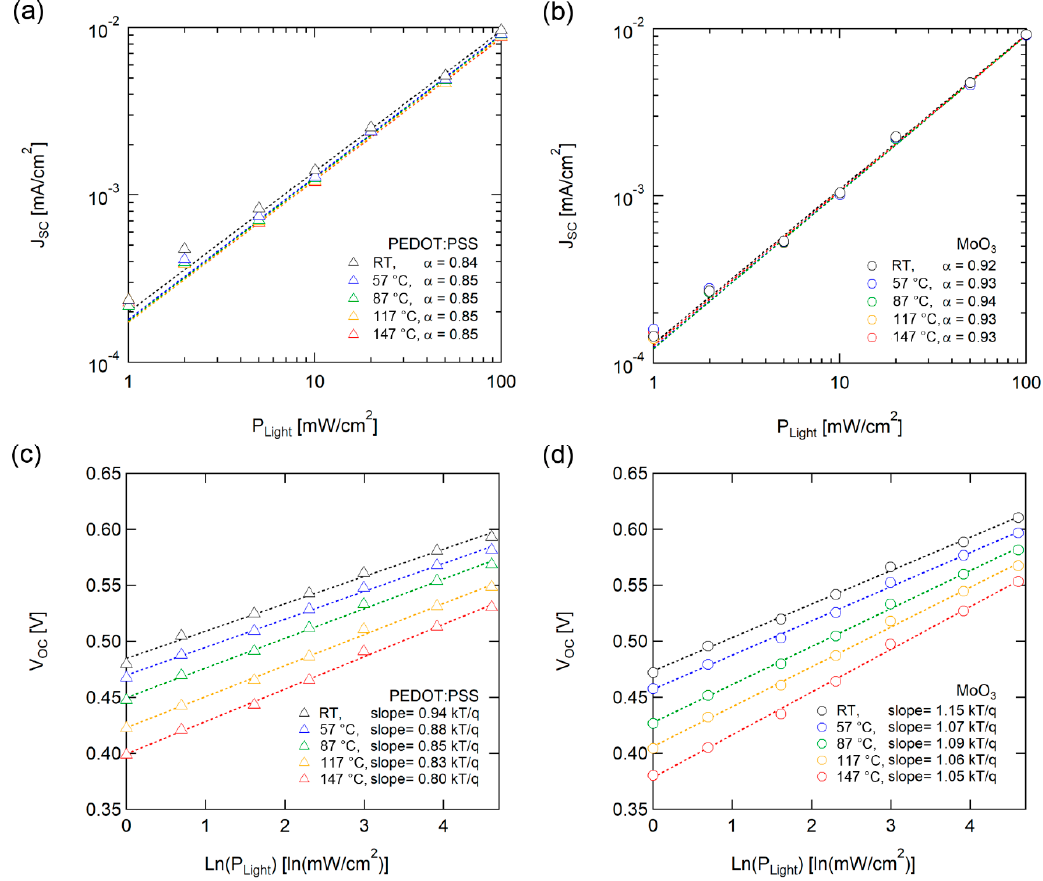
Figure 4. Light intensity dependence of ( a, b ) J SC and ( c, d ) V OC with PEDOT:PSS (left) and MoO 3 (right) as HELs. Dotted lines denote fitting lines. J sc was fitted according to J SC ~ (P light ) α , and V OC was fitted logarithmically with light intensity (ln(P light )). The fitting results are below each set of curves. Figure 4c and 4d display light intensity dependence between V OC and various